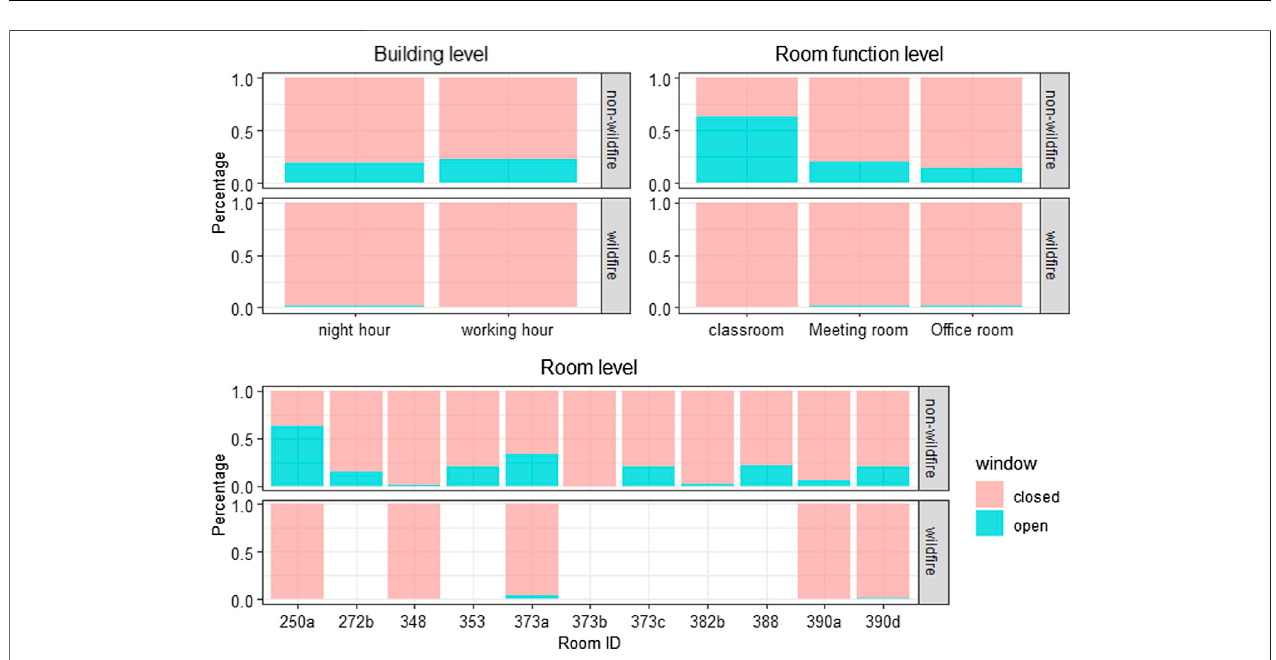
FIGURE 4 | Evaluation of indoor PM 2.5 and CO 2 concentration in different rooms.